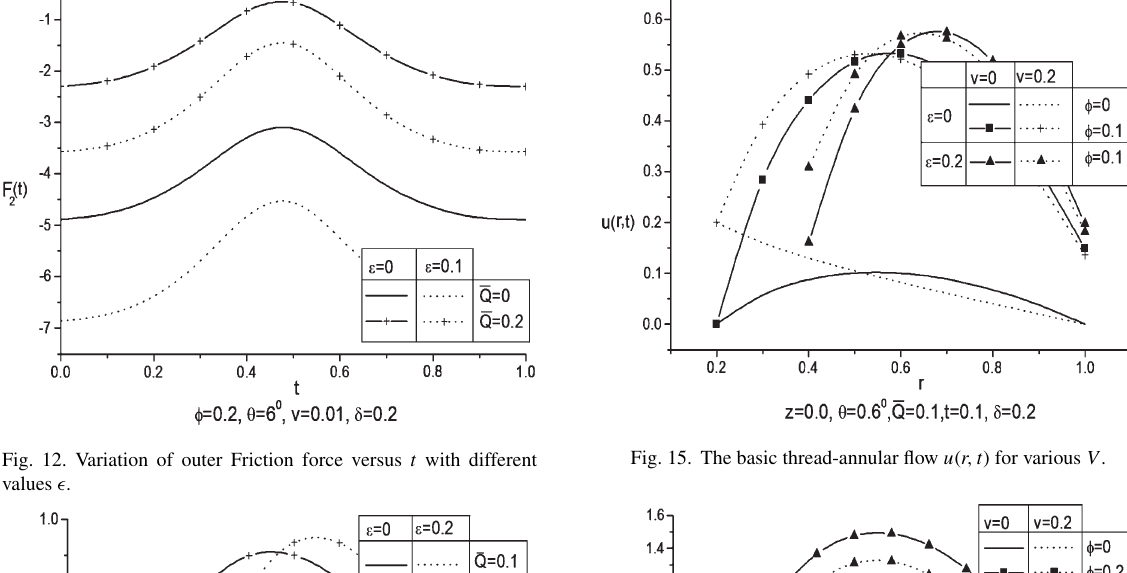
Fig. 15. The basic thread-annular flow u ( r,t ) for various V .